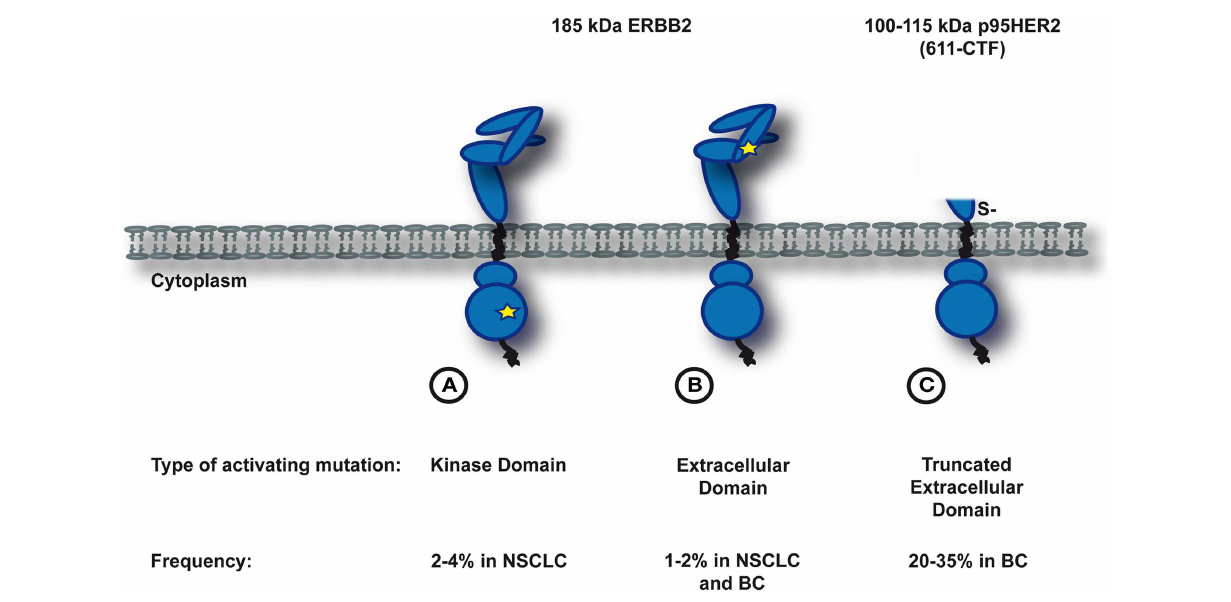
FIGURE 1 | Somatic activating mutations in ERBB2 . Depicted is a simplified schematic of three known subclasses of ERBB2-mutants. (A) and (B) Activating mutations in the full-length protein. A star indicates the position